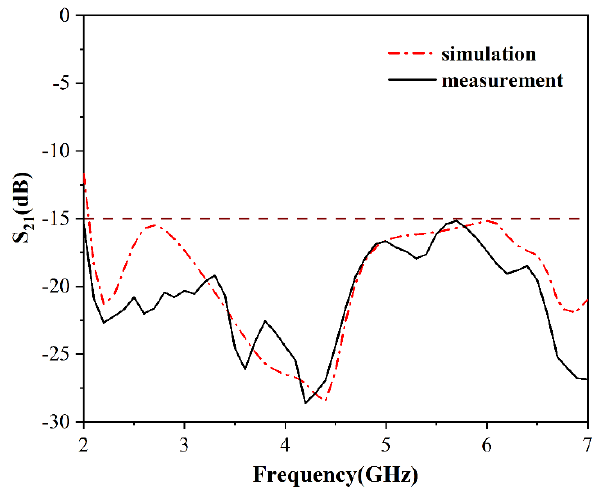
Figure 8. Simulated and measured isolation of the proposed antenna.